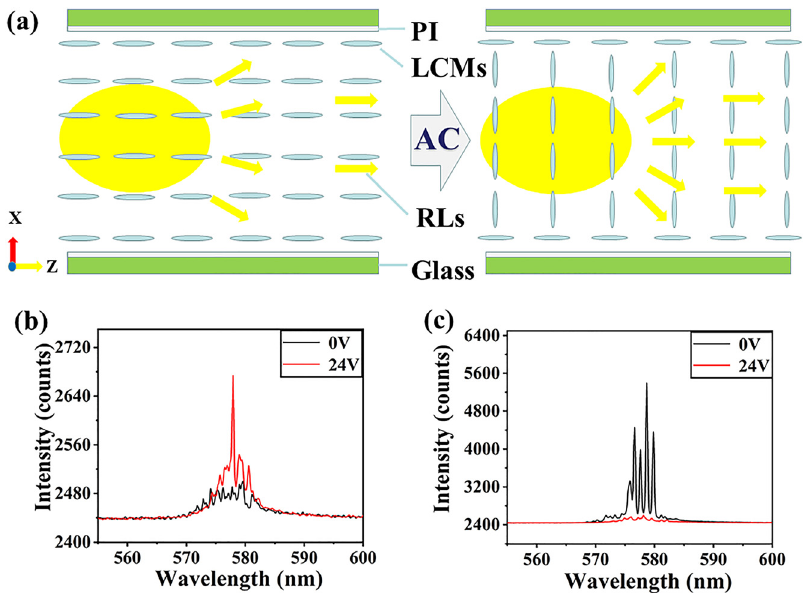
Figure 3: (a) Schematic diagram of LC molecular arrangement; Vertically (b) and horizontally (c) polarized random lasers (RLs) spectra at voltages of 0 V (black line) and 24 V (red